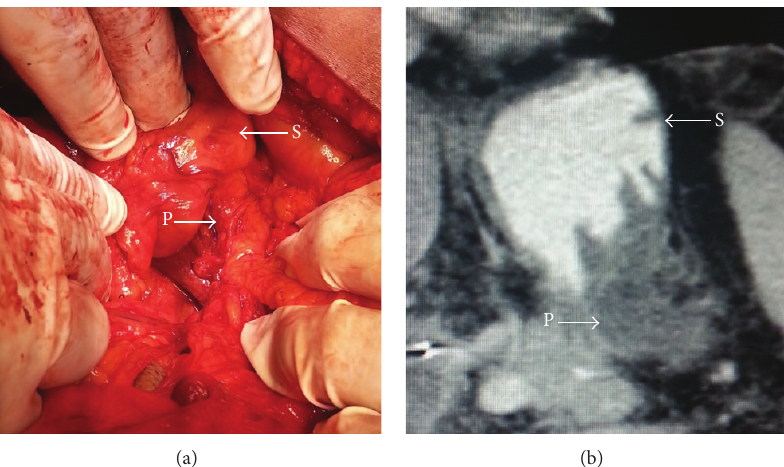
Figure 3: (a) Intraoperative invagination of the pancreatic remnant (P) into the posterior gastric wall (S); (b) postoperative CT scan showing invagination of the pancreatic remnant (P) into the posterior gastric wall (S).